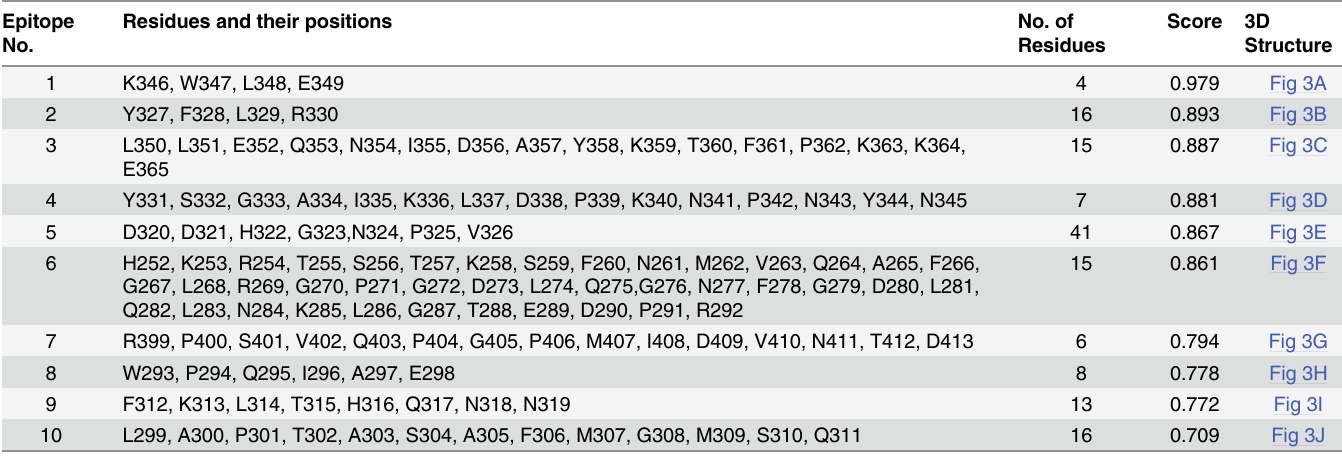
Table 3. Predicted conformational B-cell epitopes of the N protein of MERS-CoV. Epitope